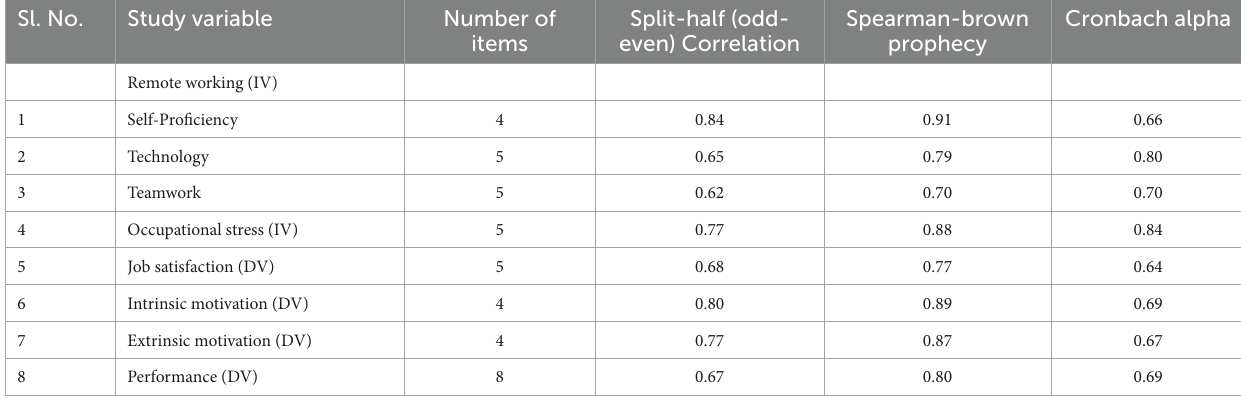
TABLE 5 Reliability statistics of the study sample. Sl. No.